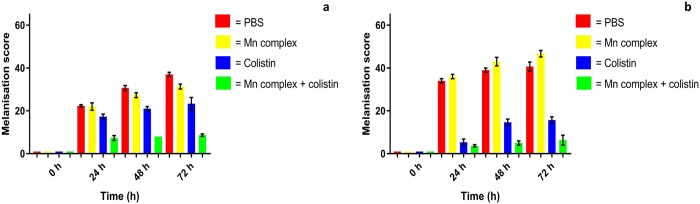
Melanisation assay in Galleria mellonella infected with 105 CFU/larvae of APEC strain a) 99/12 and b) 236/12 and treated with PBS, 20 mg/kg of [Mn(CO)3(tpa-κ3N)]Br, colistin or a combination of both agents.Higher scores indicate greater insect morbidity.